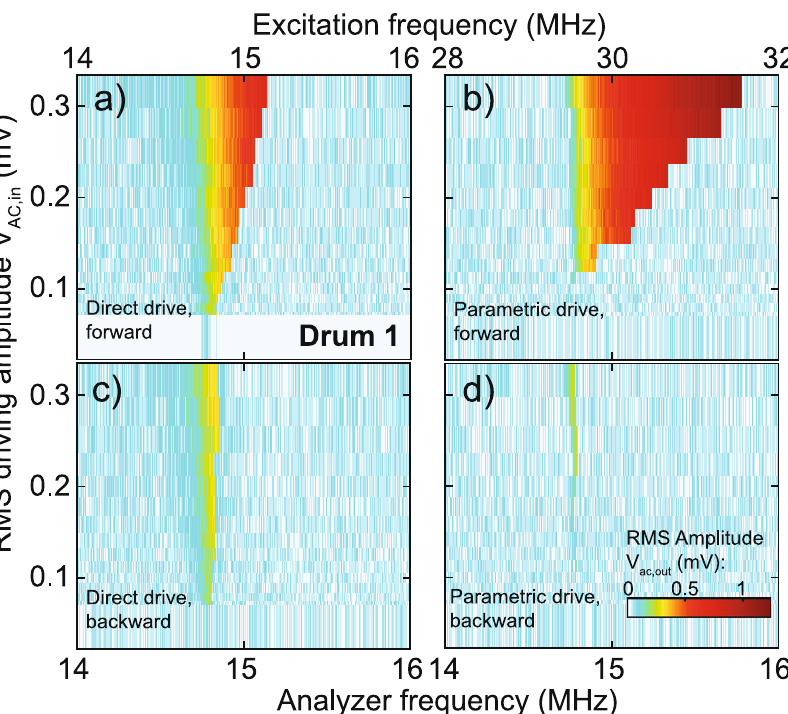
Figure 3. Frequency response of the fundamental mode to direct and parametric drive, for forward and backward frequency sweeps. ( a ) Direct drive with the frequency swept forwards. ( b ) Parametric drive with the frequency swept forwards. Below a driving threshold near V ac,in ≈ 0.11 mV (RMS) no mechanical response is observed. ( c ) Direct drive with the frequency swept backwards. ( d ) Parametric drive with the frequency swept